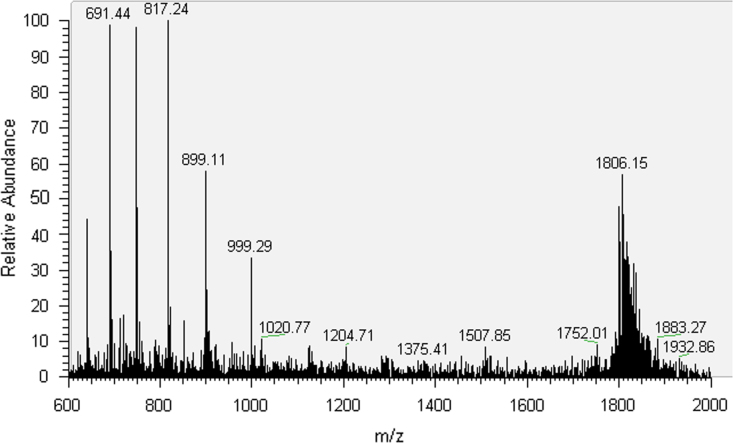
MS spectrum of 30mer-O6MeG.